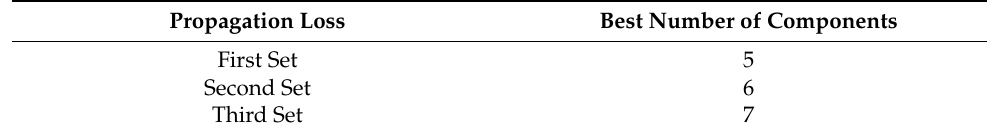
Table 6. Best number of components for three sets of measured PL